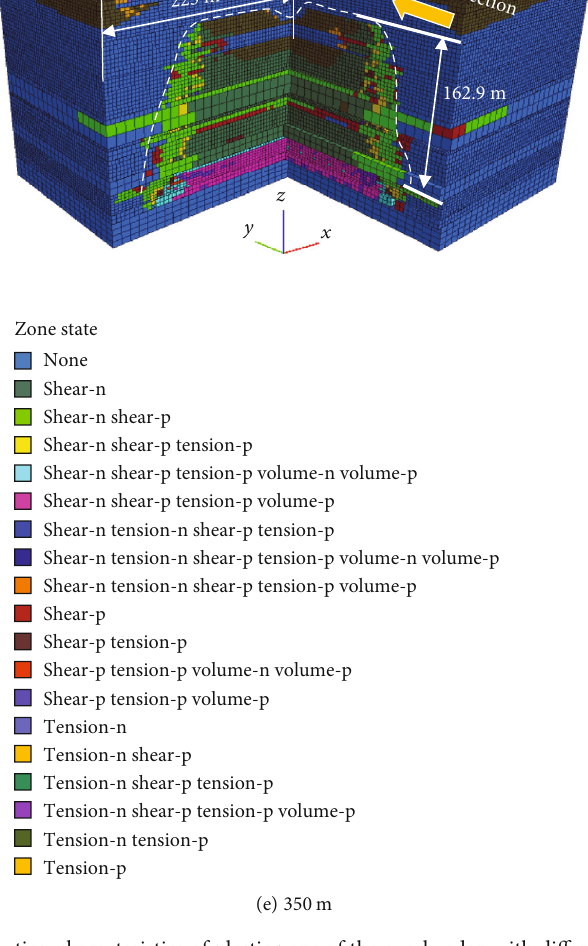
Figure 7: Distribution characteristics of plastic zone of the overburden with di ff erent panel